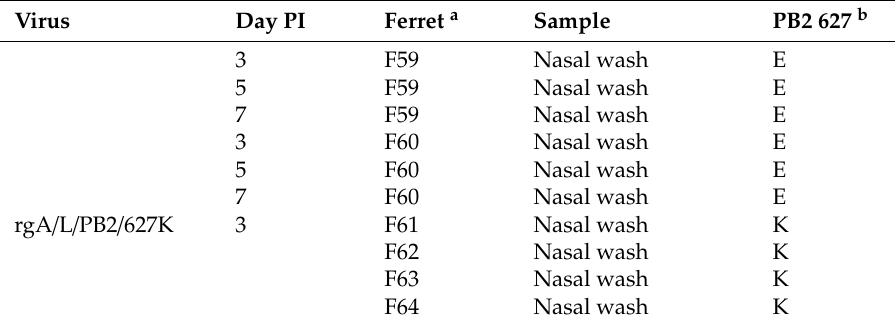
Table A4. PB2 627 sequencing following infection of ferrets with rg H5N1 viruses.